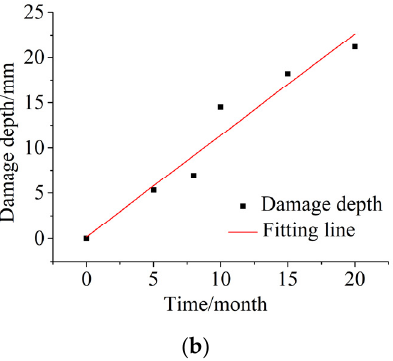
Figure 5. Damage depths of the specimens after different dry and wet cycle inspection periods. ( a ) AgNO 3 coloration method for representing the damage depth of specimens after different dry and wet cycle inspection periods. ( b ) Variation in the measured damage depth after different dry and wet cycle inspection periods.